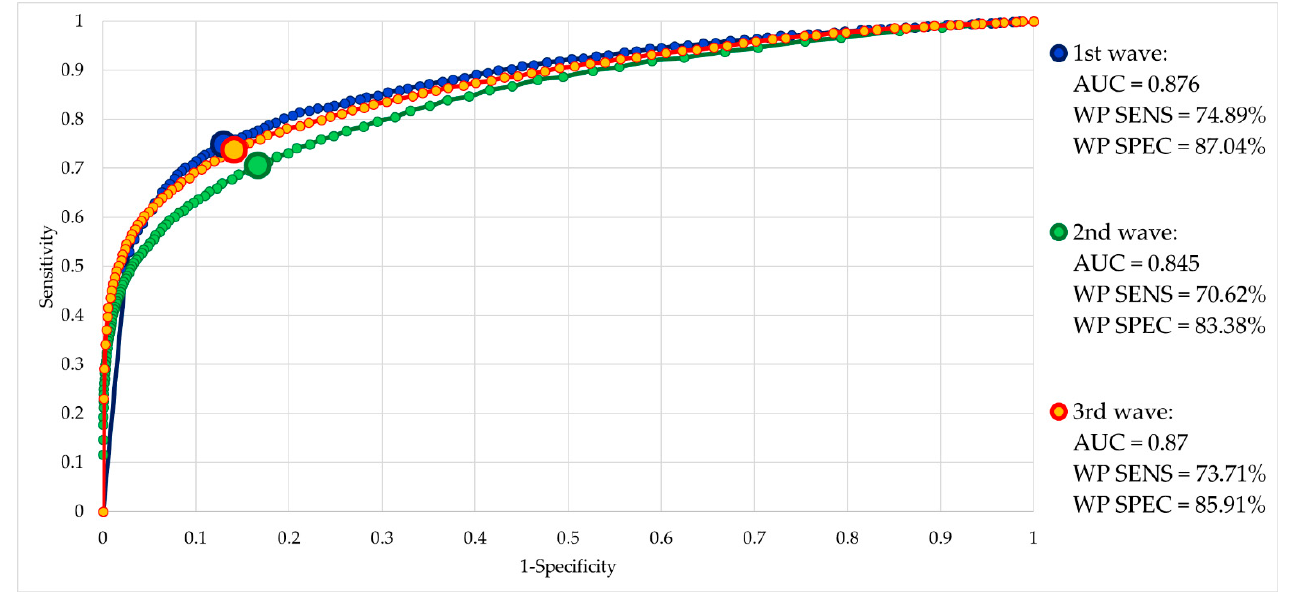
Figure 3. ROC curves representing the performance of the selected machine learning algorithm (random forest classifier) for a daily binary classification of territorial districts in the condition of the active spreading of the COVID-19 epidemic (‘1’) or no diffusion of the epidemic (‘0’) on the basis of ambulance dispatches and calls received by EMS department in Lombardy, Italy, between 1 January 2020 and 13 March 2022. The considered threshold is the label probability as provided in the output by the algorithm. The three COVID-19 waves (spring of 2020, autumn of 2020 to spring of 2021, winter of 2021–2022 to spring of 2022) were evaluated separately, training the model with the data from the other two. The area under the curve was computed, along with the sensitivity and specificity of their optimized [51] working points. Table 4. Median (25th–75th percentile) of the number of ambulances dispatched for respiratory and infective issues by the EMS department on the territory of Lombardy, Italy, relevant to the 5 classes representing the level of confidence of being in a situation of the active spread of COVID-19, assigned by post-processing from the machine learning algorithm output for each municipality, between 1 January 2020 and 13 March 2022 (see text for details); the last column reports the p -values of pairwise Wilcoxon’s rank-sum tests (after Bonferroni correction), assessing the difference in the distribution across different